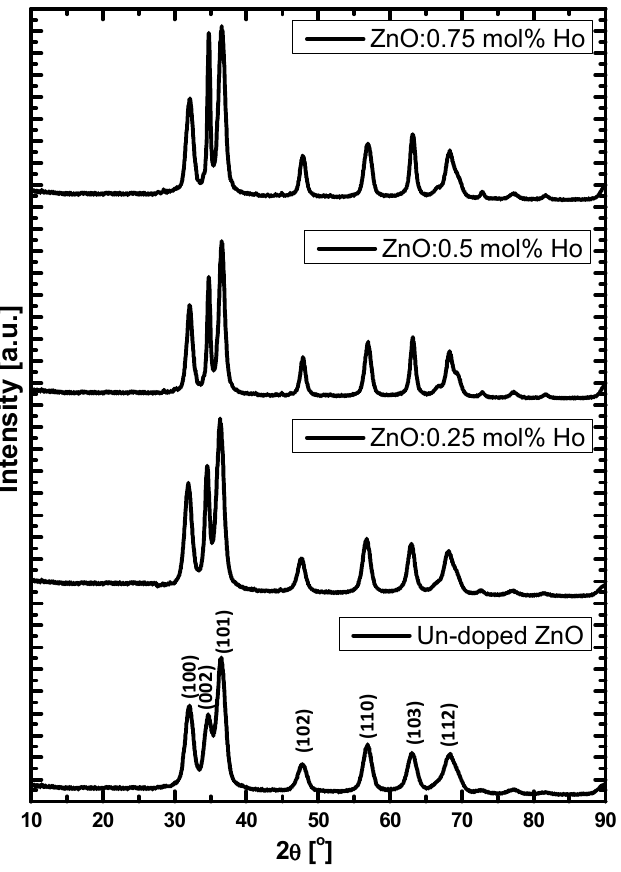
Figure 3. XRD patterns for undopedZnO and Ho 3+ -doped ZnO nanocrystals dried at 200 ◦ C. Table 1. The XRD parameters and the average estimated crystallite size (D) from Scherrer